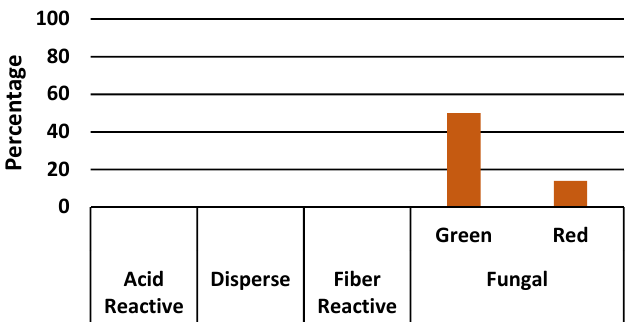
Figure 1. Results for colorfastness to washing, unmordanted.